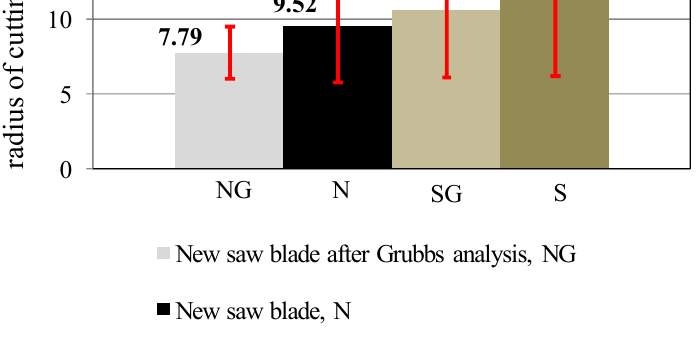
Figure 5. Mean values of the cutting edge radii with standard deviations.